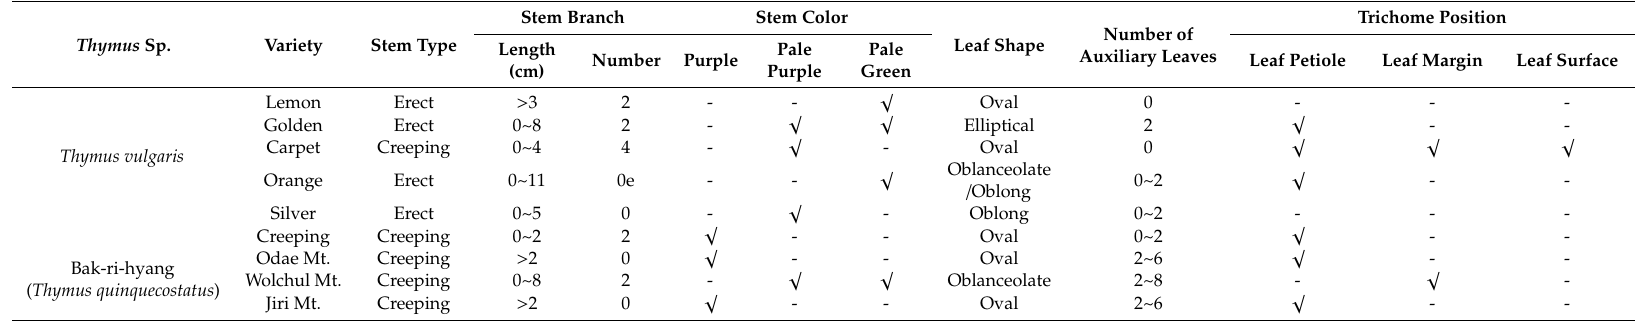
Table 2. Morphological characteristics of six commercial Thymus vulgaris cultivars and three Korean native Thymus quinquecostatus cultivars. Thymus Sp.